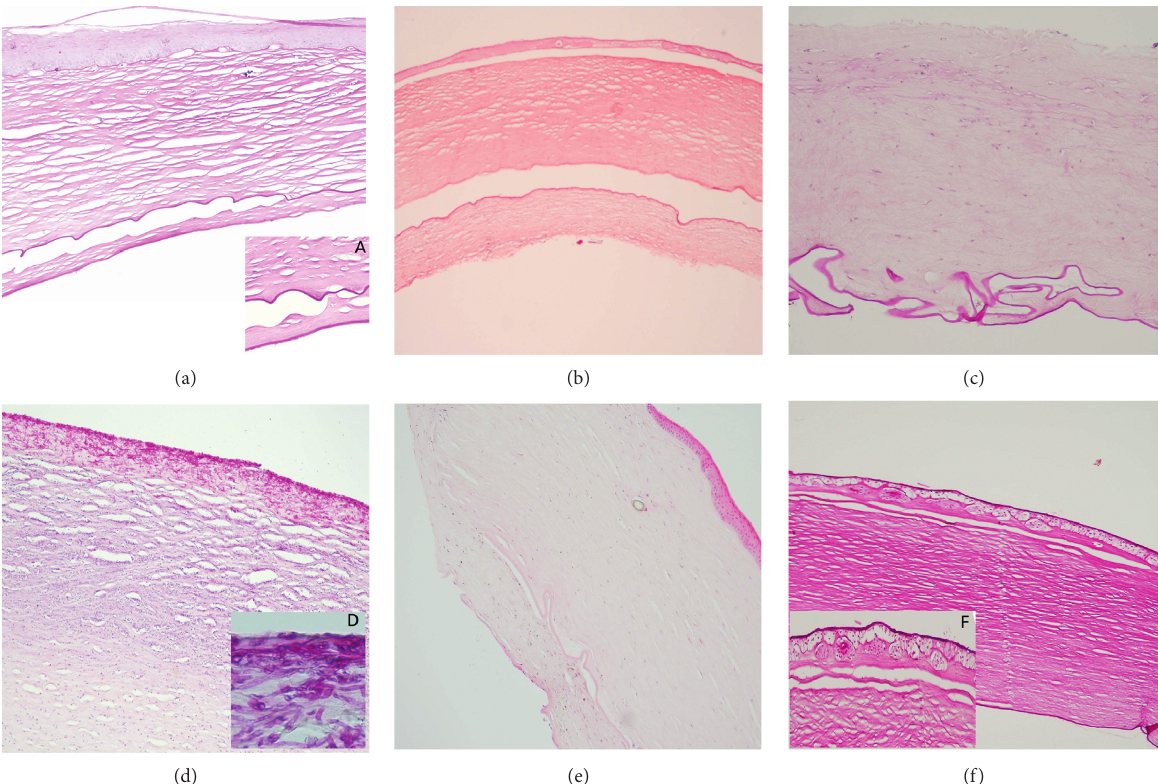
Figure 2: Pathological findings in the regrafted corneas with staining of periodic acid-Schiff (PAS). (a) Descemet membrane doubling and fibrous ingrowth (magnification; (a) × 40 and (b) × 400). (c) Descemet membrane misplacement ( × 40). (d) Descemet membrane excretions ( × 200). (e) Fungal keratitis ((e) × 40 and (f) × 400). (g) Retrocorneal fibrous ingrowth ( × 100). (h) subepithelial pannus ((h) × 40 and (i) ×